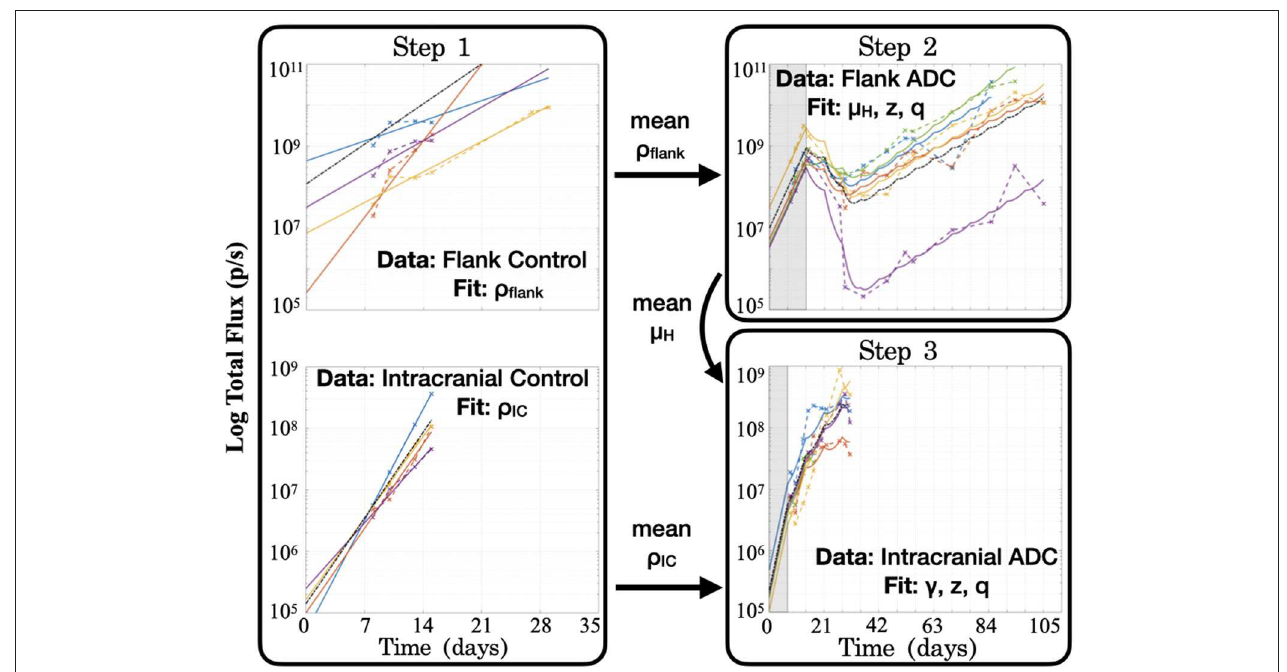
FIGURE 3 | Summary of the series of steps used to estimate model parameter values through fitting the model to different experimental data sets. Step 1 consists of two separate fittings for the two different tumor locations, and the mean ρ values are passed for use in subsequent steps in the respective tumor sites, while the mean µ H value from the flank found in Step 2 is passed for use in Step 3 . Shaded regions for Steps 2 and 3 indicate time prior to initiation of treatment with the ADC. Black dash–dot lines in each plot are simulations using the averaged fitted parameter values across all subjects within the group. It is worth noting that at each step, no more than three parameters are fitted to the data, in order to ensure identifiability and prevent